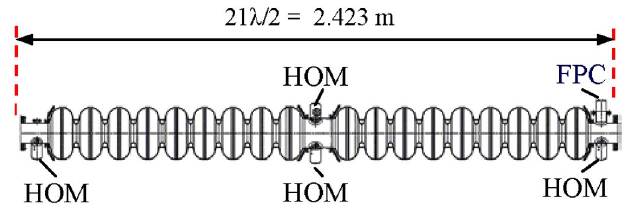
FIG. 11. (Color) 2 (cid:1) 9 -cell SSTwith additional space of 2 (cid:27)= 2 at both sides. Note that these 18 cells are equipped with only one FPC and four HOM couplers.